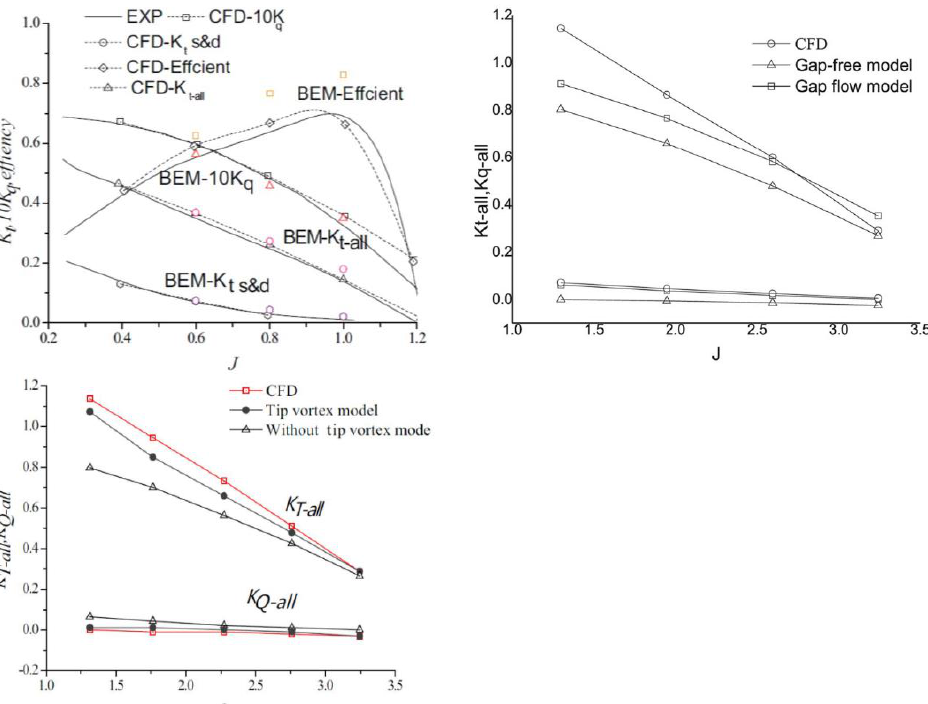
Figure 3. Comparison of open-water performance results on whole conditions [42,43].